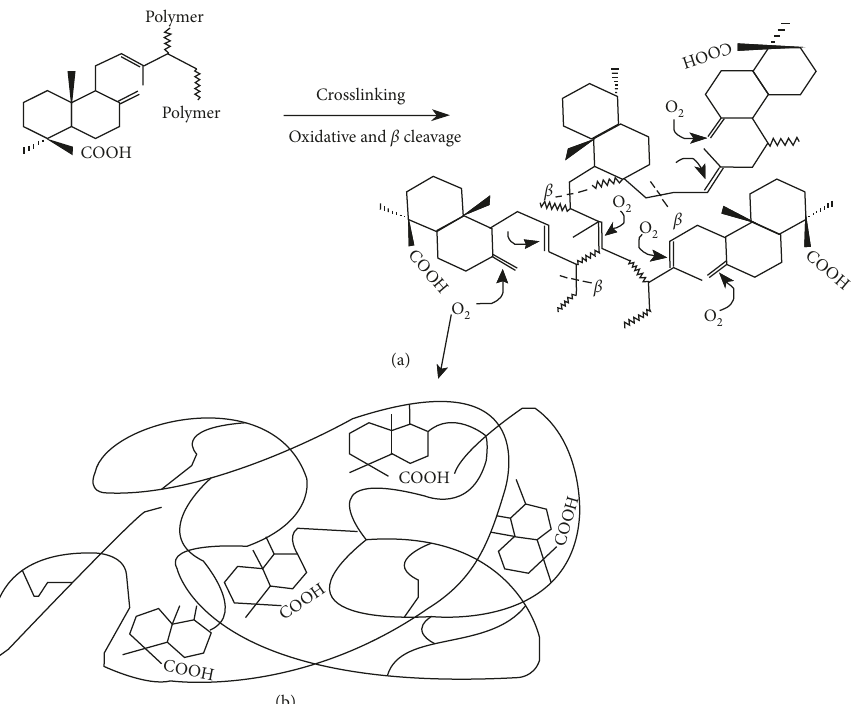
Figure 5: Amber formation via a crosslinking polymerization process (as proposed in [9]).